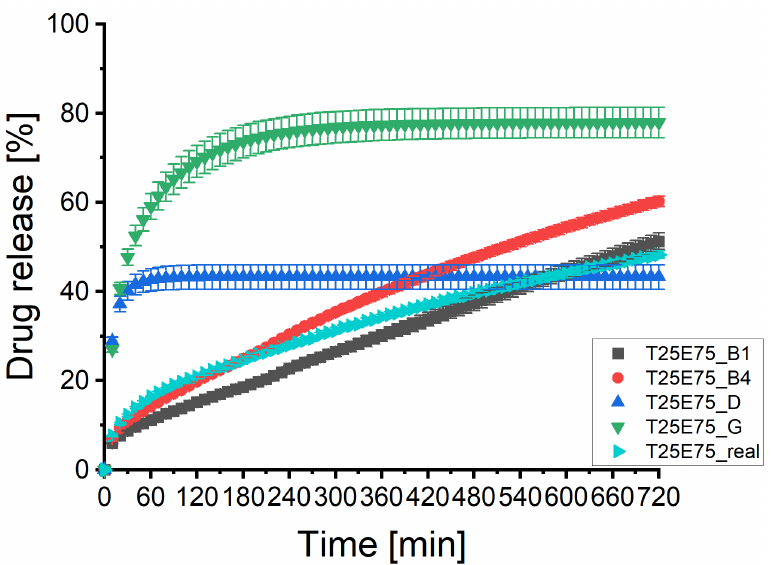
Figure 4. The predicted dissolution profiles of two image processing pathways of the imaged tablets 1, 3, and 5 of batch T25E75 ( ¯ x SD , n = 3). The experimental determined dissolution profile is ± depicted as well.